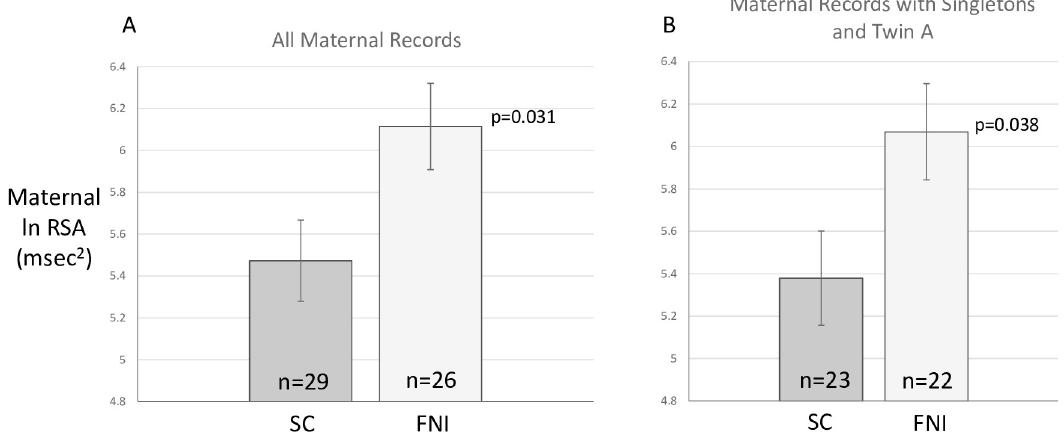
Fig 3. Means ( ± SE) of RSA for mothers at their child’s 4 to 5 year follow-up during the lap-test. The set of bars on the left show results for all children. These studies of mothers reflect multiple measures from some mothers tested with both of their twins. The set of bars on the right show results when including only singletons and twin